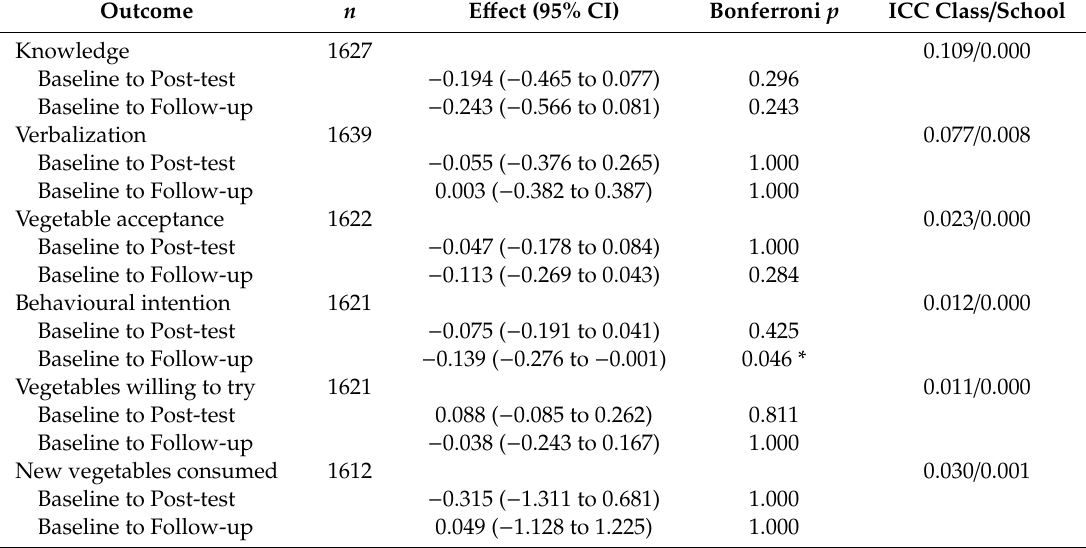
Table 3. Di ff erence between low- and high-intensity teacher training preceding teaching the vegetable education program on student outcomes over time.